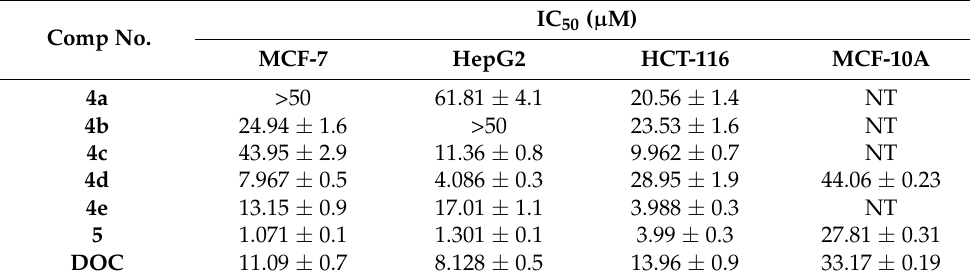
Table 1. In vitro IC 50 values ( µ M) of imidazole derivatives 4a – e and 5 over MCF-7, HepG2, HCT-116, and MCF-10A cell lines. Data are expressed as the mean ± three experiments. Comp No.